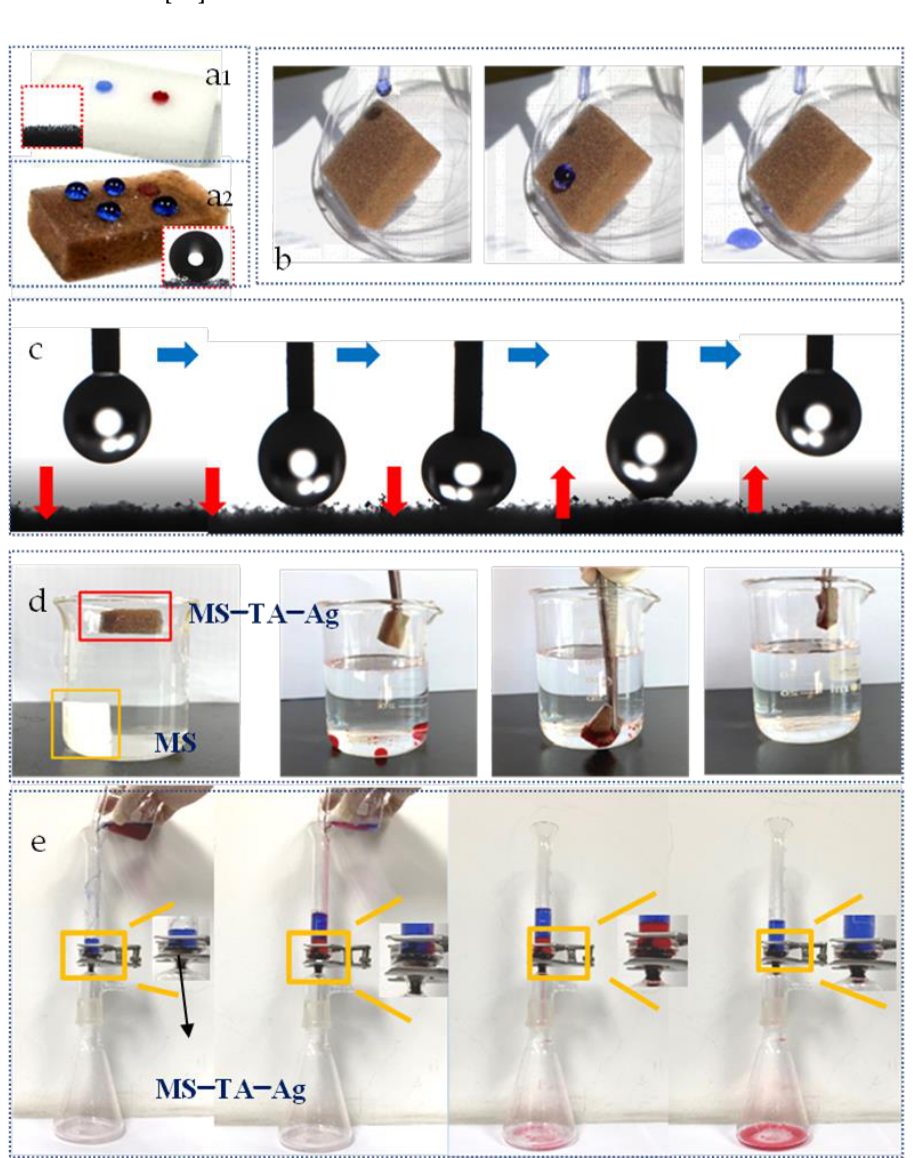
Figure 5. Photographs of dripping water and dichloromethane on the MS ( a 1 ) and MS–TA–Ag ( a 2 ). The rolling photos of water droplets on modified MS ( b ). Digital photograph of dynamic contact modified sponge ( c ). The state of sponges in water ( d ). The oil absorption experiment under water for modified MS ( e ). The separation test of dichloromethane and water for the modified MS ( f ).